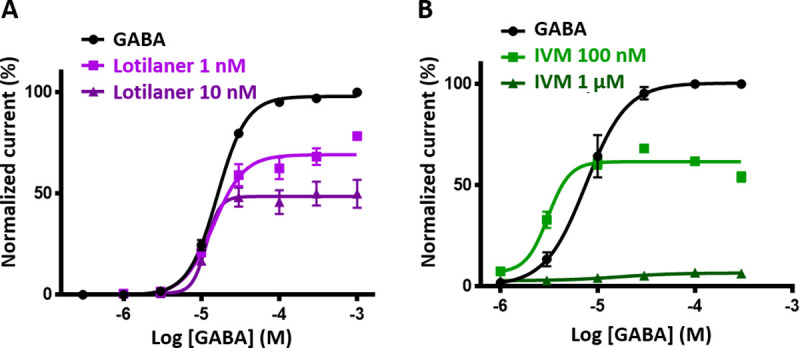
Competitive assay for lotilaner and ivermectin on Phh-RDL.A. Lotilaner is a non-competitive antagonist of Phh-RDL. GABA concentration-response curves were performed with GABA alone (black circles) or with lotilaner at 1 nM (purple squares) and 10 nM (purple triangles). Data were normalized to a first application of 100 μM GABA (mean +/- SEM, n = 5–6). B. Dual action of ivermectin on Phh-RDL. GABA concentration response were performed with GABA alone (black circles) or with ivermectin at 100 nM (green squares) and 1 μM (green triangles). Data were normalized to a first application of 100 μM GABA (mean +/- SEM, n = 5–6).